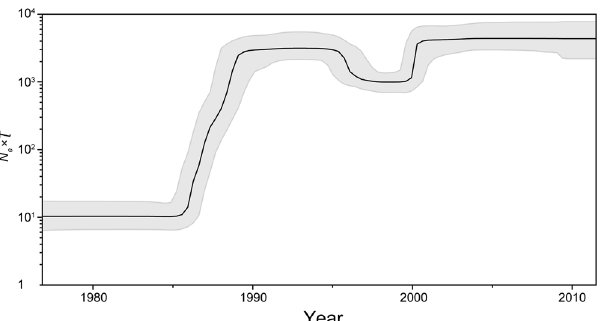
Figure 4. Bayesian skyline demographic reconstruction of HIV-1 CRF01_AE. The vertical axis shows the effective number of infections ( N e ) multiplied by mean viral generation time ( τ ). The solid line and shaded region represent the median and 95% credibility interval of N e τ through